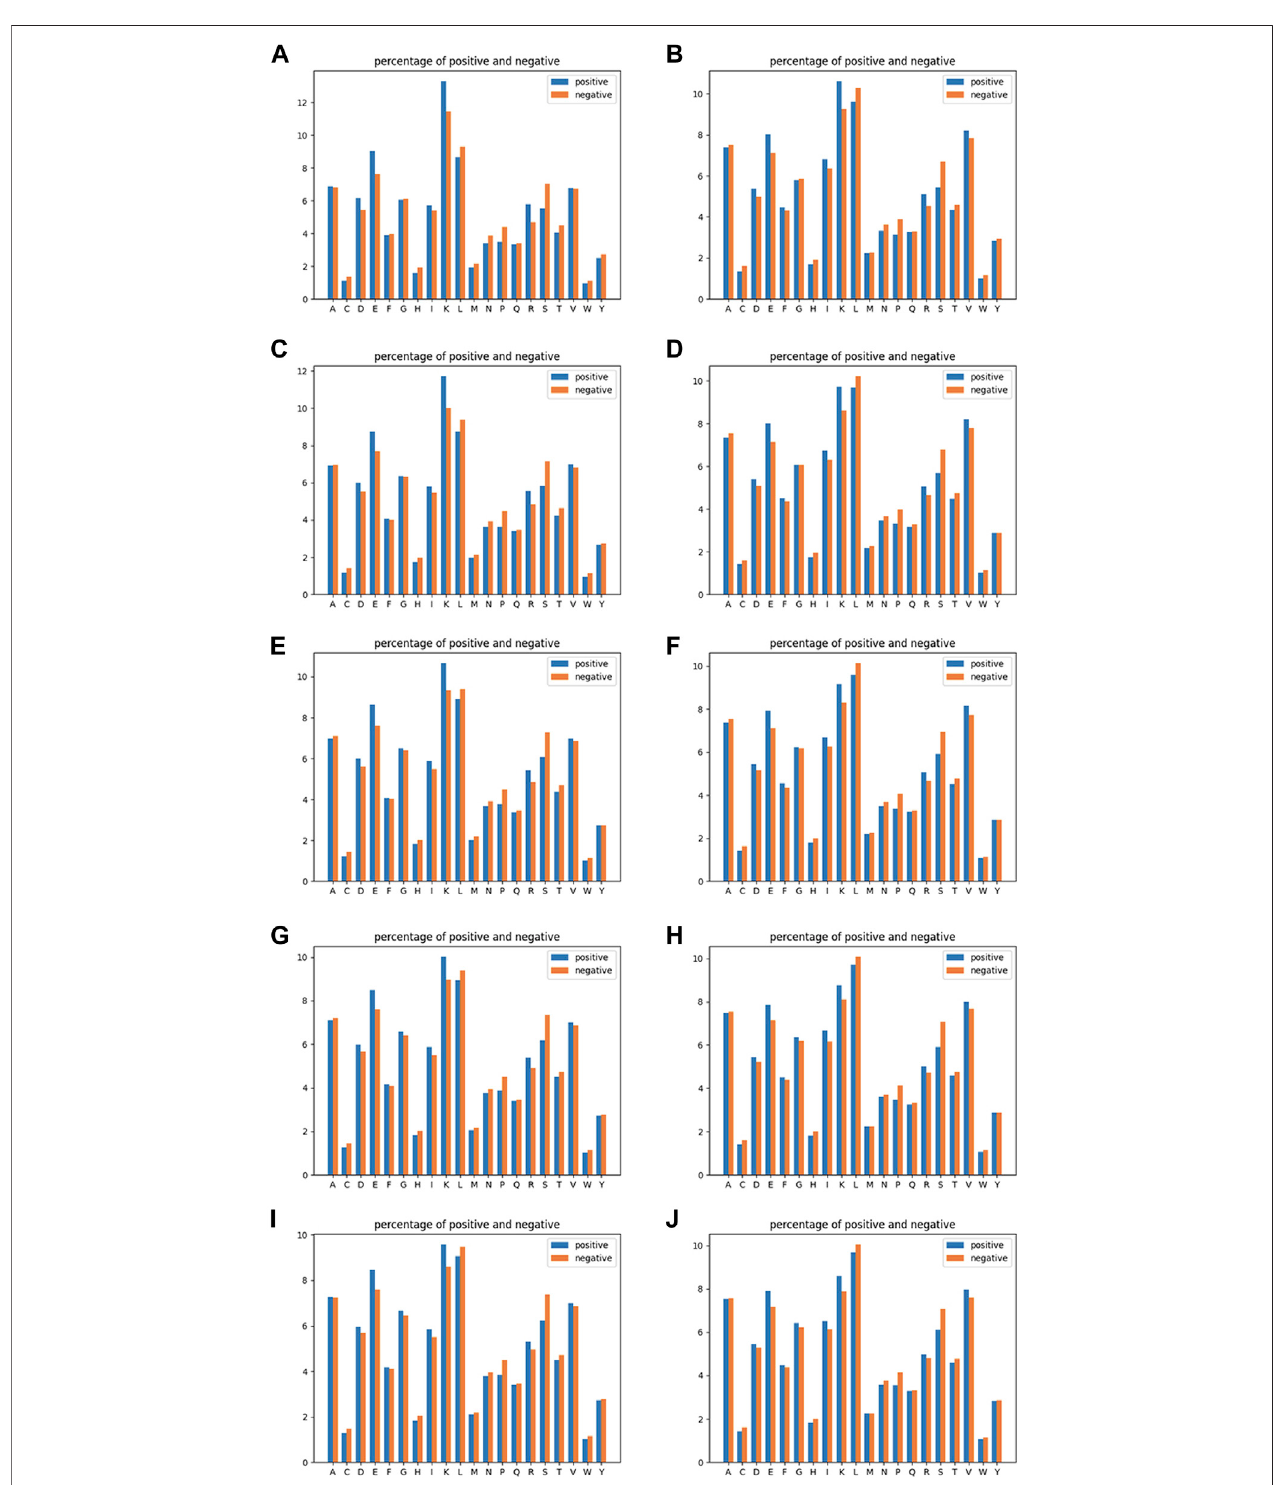
FIGURE 2 | Amino acid composition analysis of linear feature AAC (the left-column fi gures) and spatial contacted feature RRC (the right-column fi gures). The fi ve rowscorrespondtowindowsizesof10,15,20,25,and30fromthetoptothebottom.Indetail, (A) AACofawindowsizeof10, (B) RRCofawindowsizeof10, (C) AAC of a window size of 15, (D) RRC of a window size of 15, (E) AAC of a window size of 20, (F) RRC of a window size of 20, (G) AAC of a window size of 25, (H) RRC of a window size of 25, (I) AAC of a window size of 30, and (J) RRC of a window size of 30.